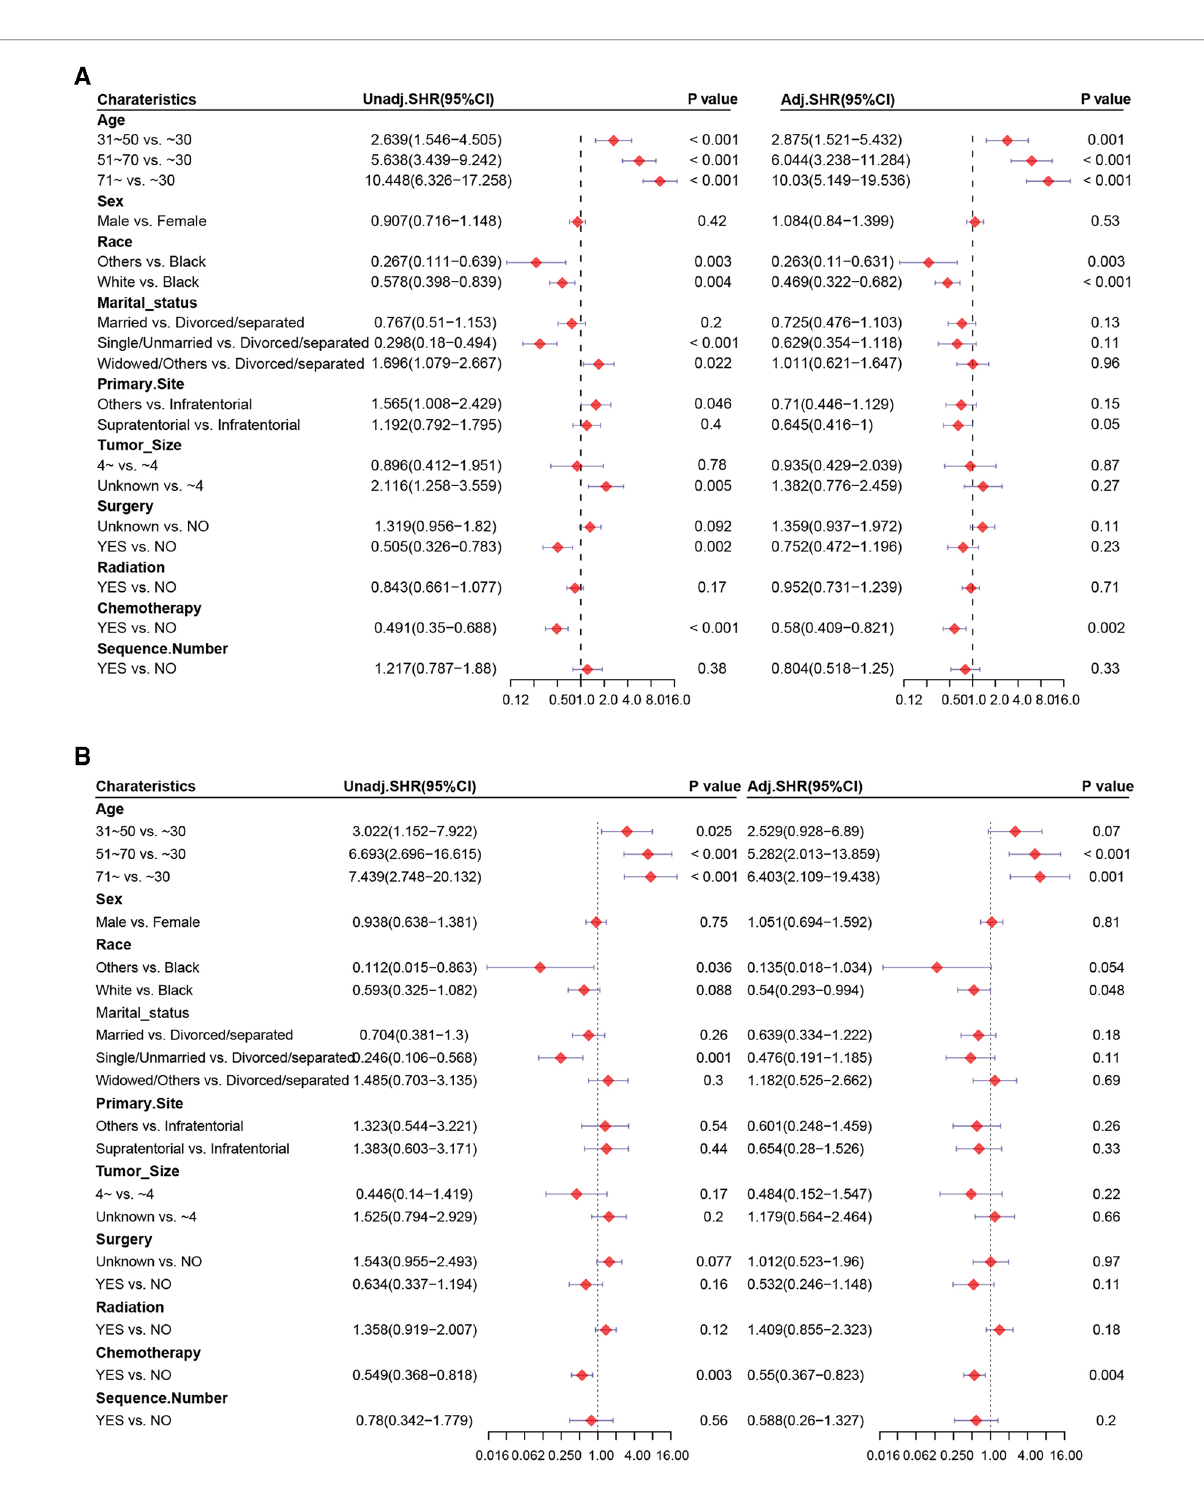
FIGURE 4 Forest plots of univariate and multivariate Cox regression analysis. Univariate and multivariate Cox regression analysis of chemotherapy ( A ) before and ( B ) after